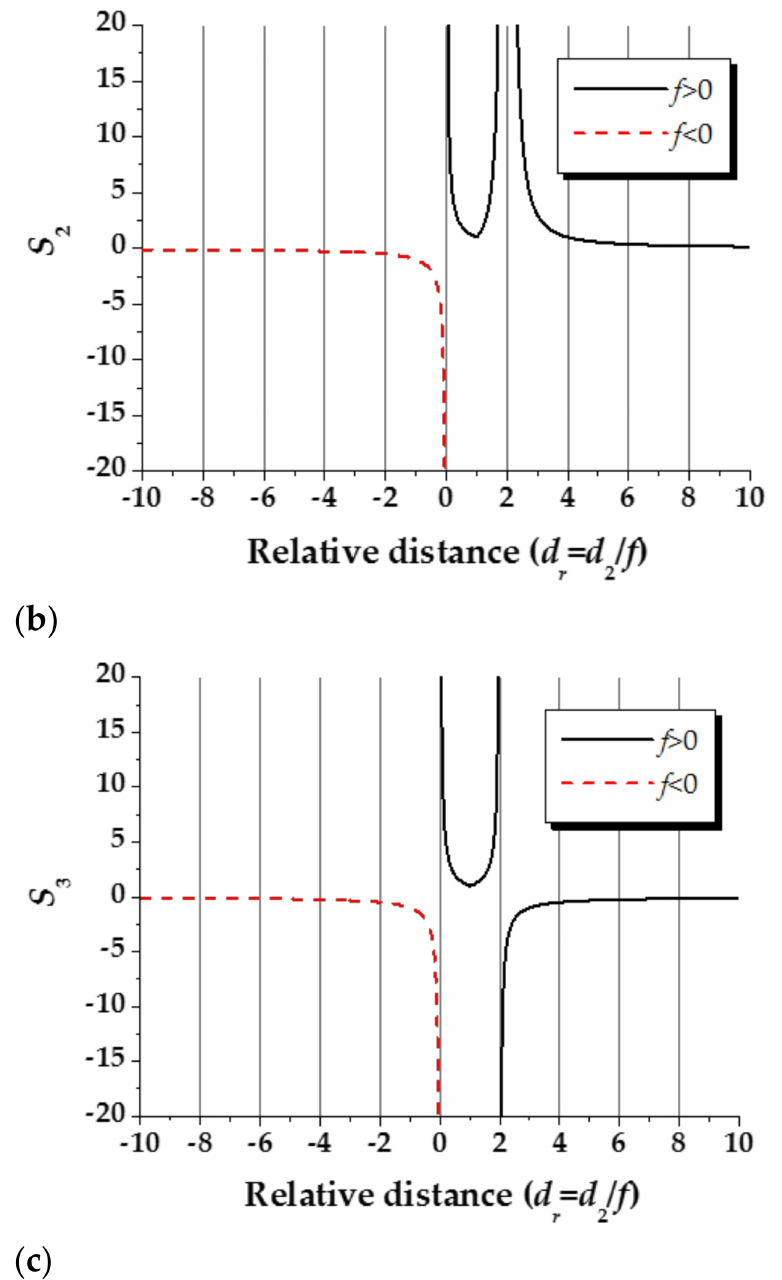
Figure 8. Relationships of ( a ) S 1 versus relative distance d r , ( b ) S 2 versus relative distance d r , and ( c ) S 3 versus relative distance d r